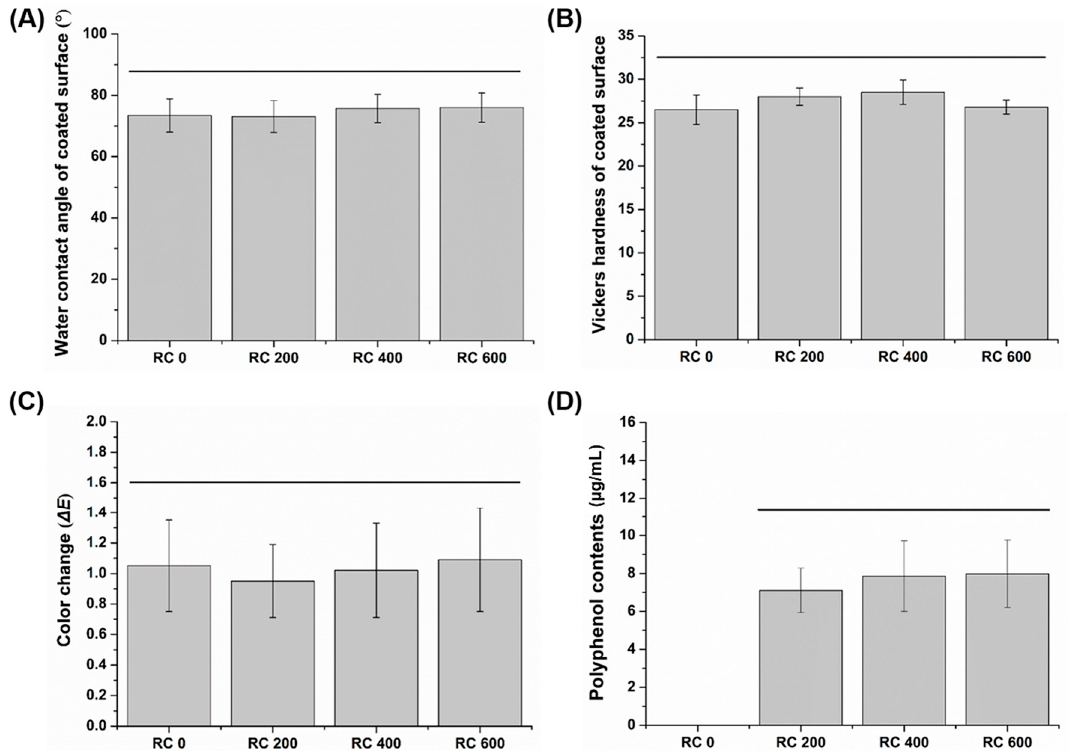
Figure 1. Bar graphs showing the ( A ) water contact angles, ( B ) Vickers microhardness, ( C ) color change before and after the coating treatment of the surfaces of the control and experimental groups, and ( D ) the amount of released polyphenol from the control and experimental groups. Each value shows the average of five measurements, and the error bar indicates the standard deviation of the average. The horizontal bar indicates no significant differences between groups ( p > 0.05).